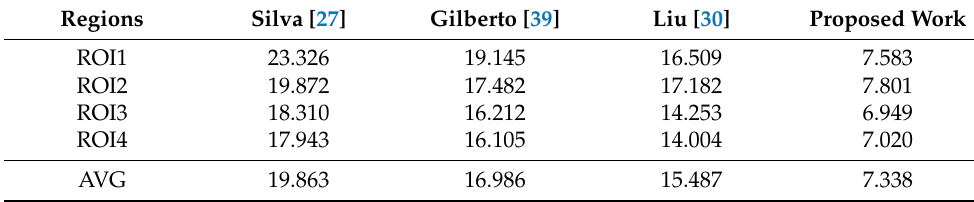
Table 3. Quantitative evaluation results of shadow standard deviation index (SSDI). Regions